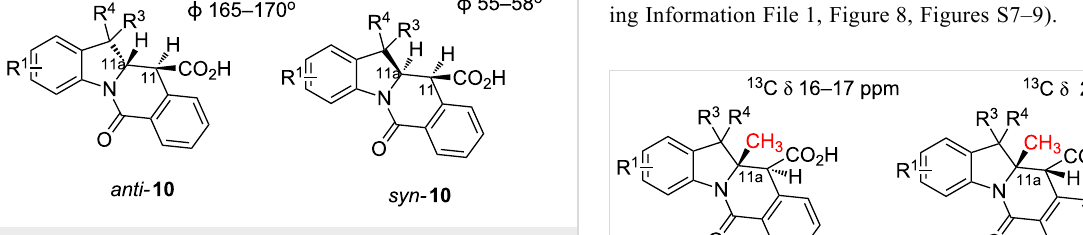
Figure 6: Typical J (H 11 -H 11a )-values and corresponding dihedral angles for syn- and anti -diastereomers of compounds 10 derived from 2 H -indolenines.